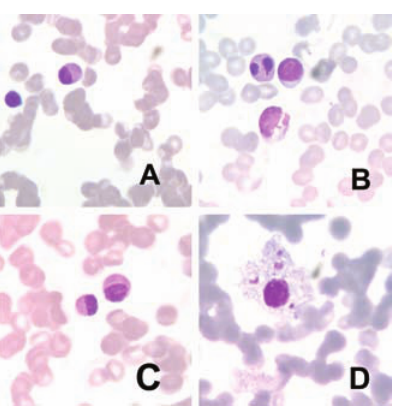
Figure 1. Pelger-Huët anomaly with a uni- lobed ovoid nucleus. The nucleus is small- er with more compact and densely staining chromatin on the peripheral blood smear (A) and bone marrow aspiration (C) (Wright-Giemsa, 100×, oil immersion). Pelger-Huët anomaly with bilobed poly- morphonuclear leukocyte with a short, thick nucleus and dense, darkly staining chromatin, most consistent with a mature PMN on the peripheral blood smear (B) (Wright-Giemsa, 100×, oil immersion). Bone marrow aspirate of the patient show- ing phagocytosis of platelets (D) (Wright- Giemsa, 100×,